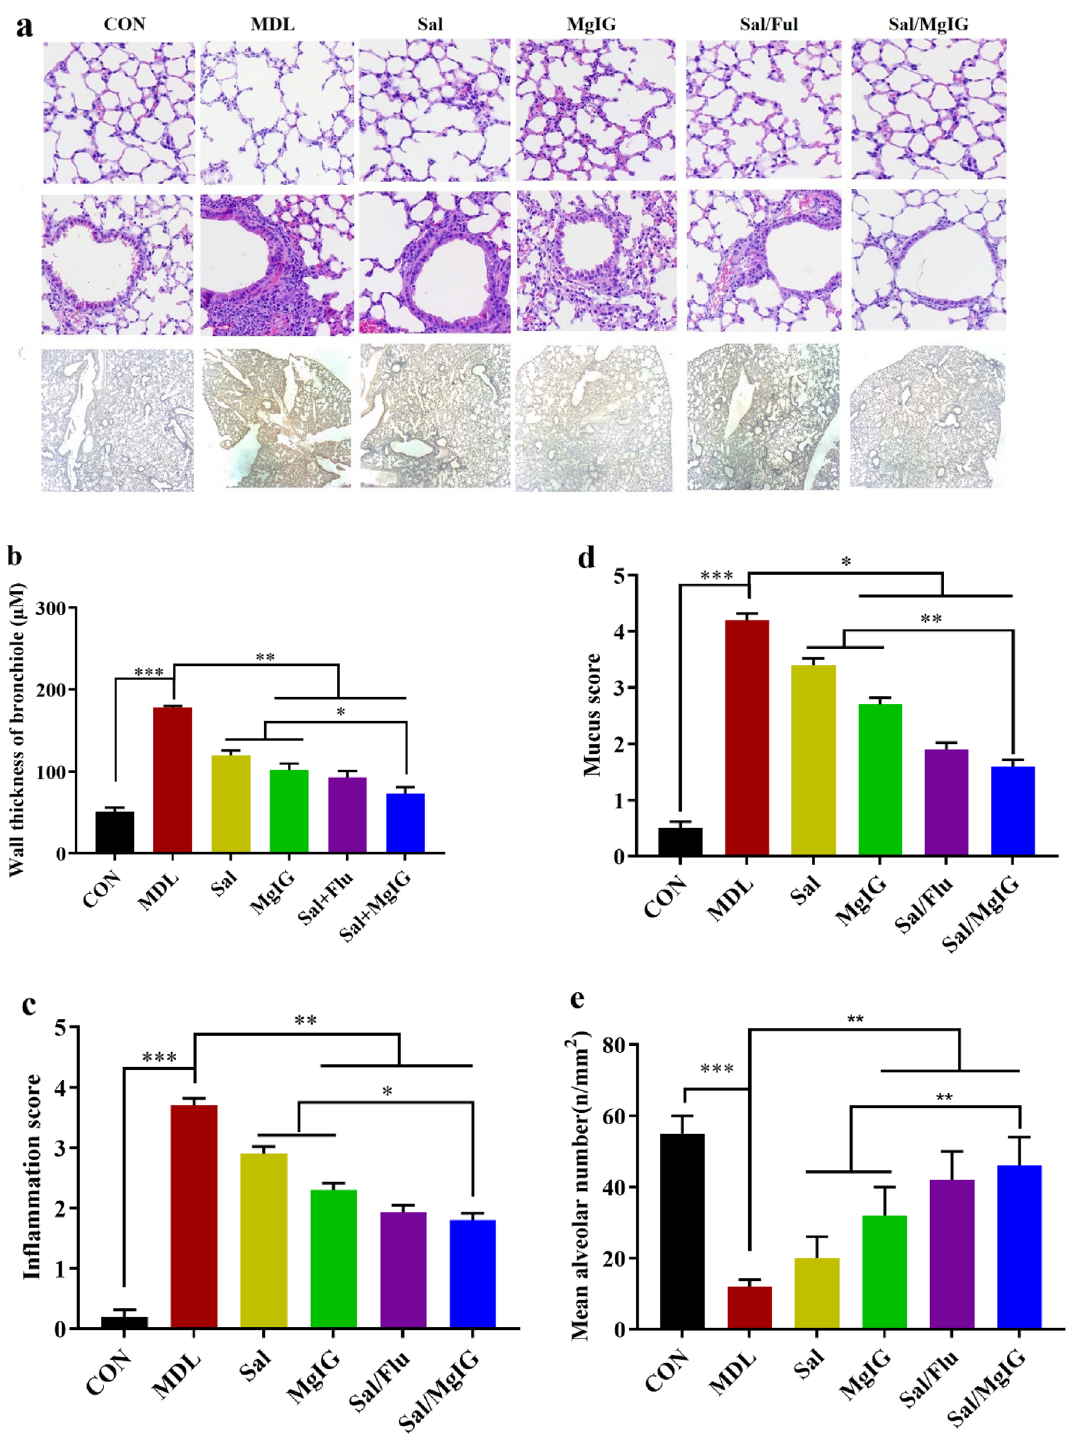
Figure 3. Effect of MgIG and/or Sal on histopathology in rats with COPD. ( a ) The images show the alveoli (H&E ×200) and airway (H&E ×200 or H&E ×100). ( b–e ), bronchial wall thickness, inflammation score, the mean chord length, mucus score and mean alveolar volume were measured to compare the effect of MgIG and/or Sal in rats with COPD. All data were presented as mean ± standard deviation. Statistical significance of differences were determined by one-way ANOVA. ***p < 0.001, **p < 0.01 and *p < 0.05 was considered to indicate a statistically significant